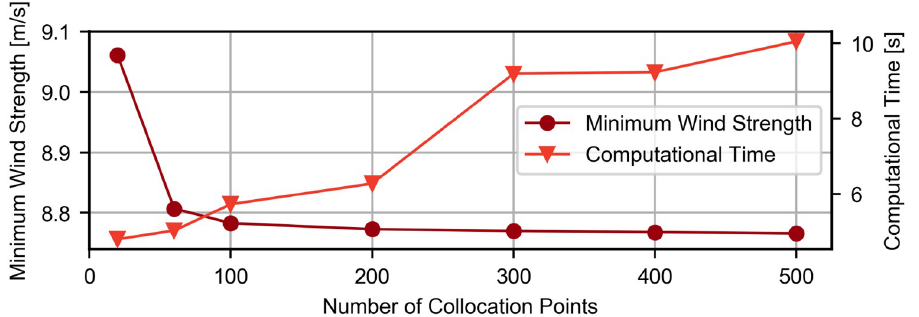
Fig 16. Convergence study. Accuracy and convergence study of the optimization